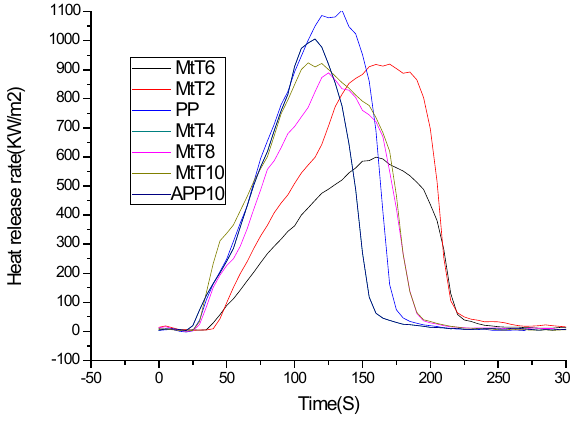
Figure 8: HRR of PP and APP10% and MtT2, MtT4, MtT6, MtT8,